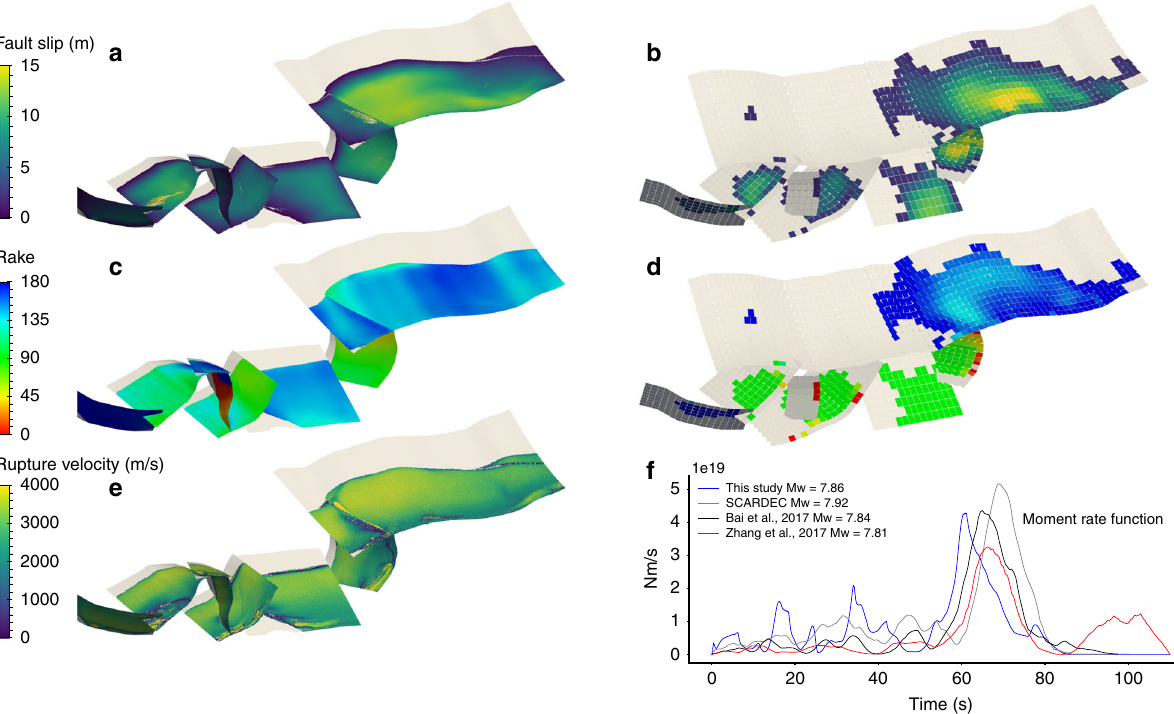
Fig. 5 Source properties of the dynamic rupture model and comparison to observational inferences. Final slip magnitude a modeled here and b inferred by Xu et al. 7 Final rake angle c modeled and d inferred by Xu et al. 7 e Modeled rupture velocity. f Modeled moment rate function compared with those inferred by Bai et al. 9 from teleseismic and tsunami data, by Zhang et al. 8 from seismic waveform inversion and from teleseismic data by the SCARDEC method 44